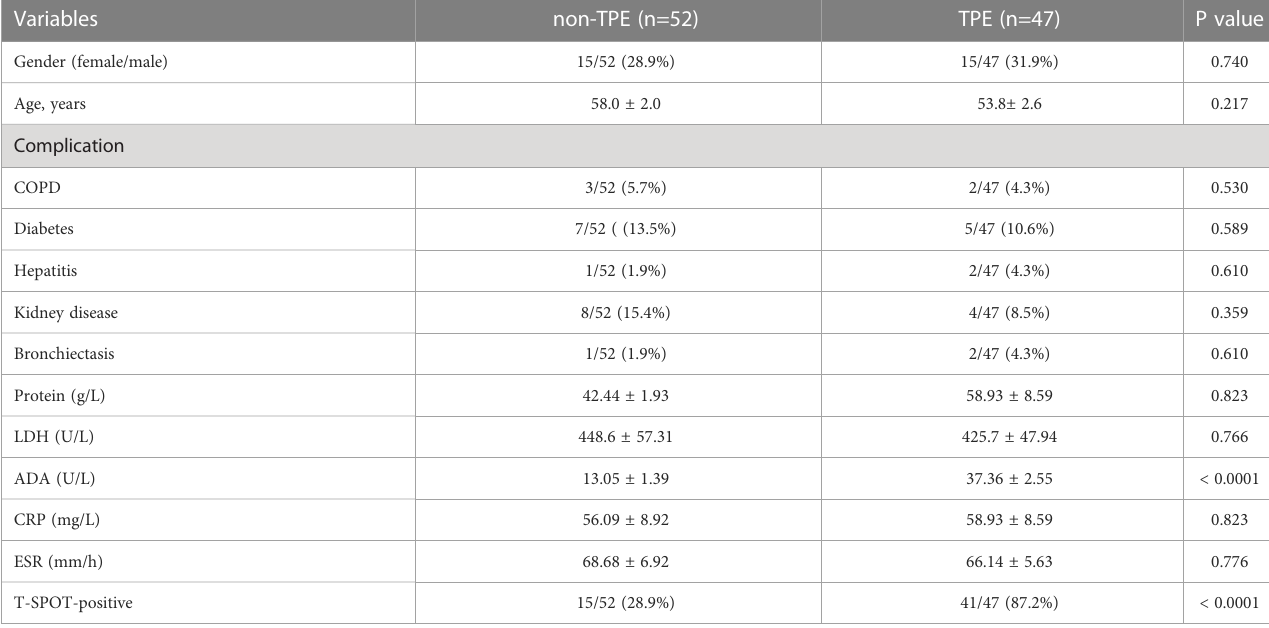
TABLE 1 Baseline demographic information and laboratory test.